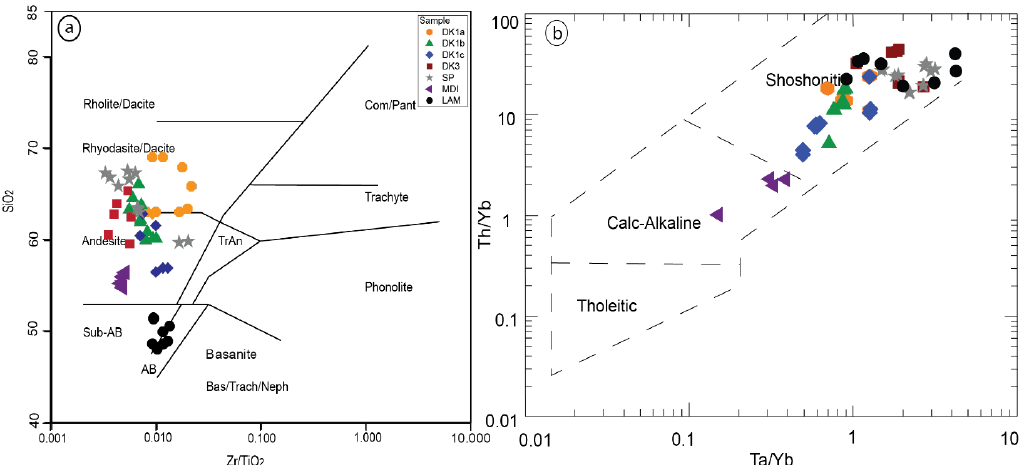
Figure 11. General classification of igneous rocks in the Sungun area. ( a ) SiO 2 vs. Zr/Ti classification diagram for the Sungun dykes [35]; and ( b ) Ta/Yb-Th/Yb diagram [36].